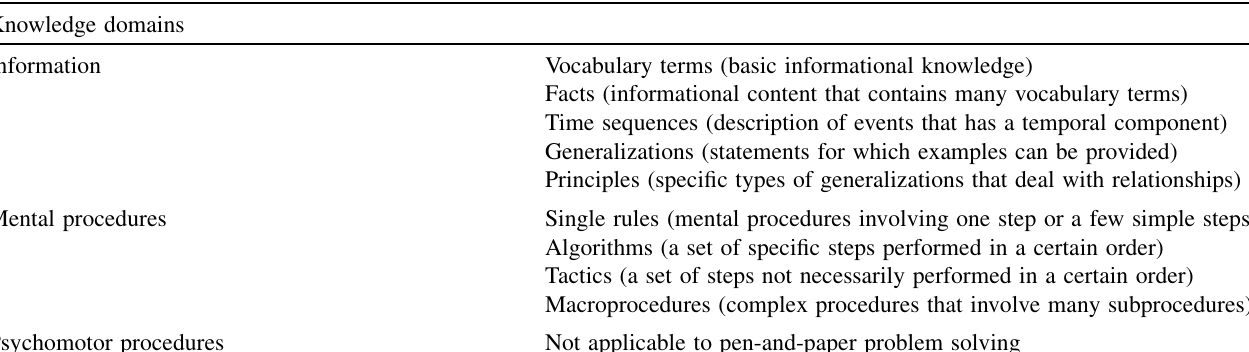
TABLE I. Summary of the knowledge domains according to NTEO [26].